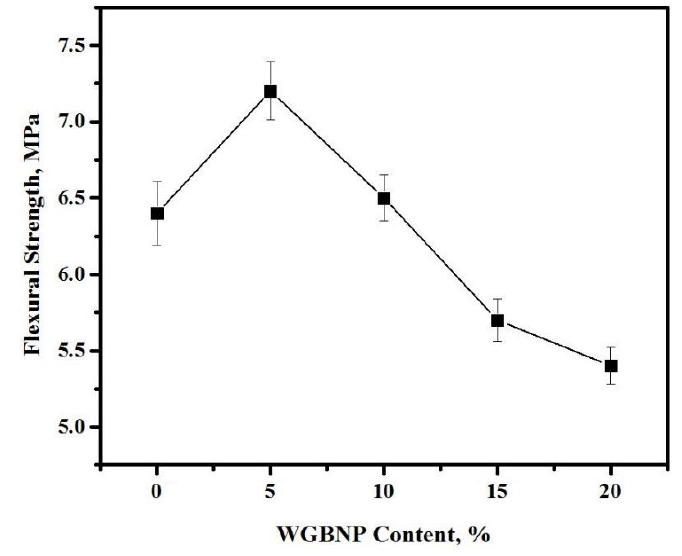
Figure 7. Influence of AAMs flexural strength by BGWNP content. Figure 7 . Influence of AAMs flexural strength by BGWNP content . Figure 7 . Influence of AAMs flexural strength by BGWNP content .